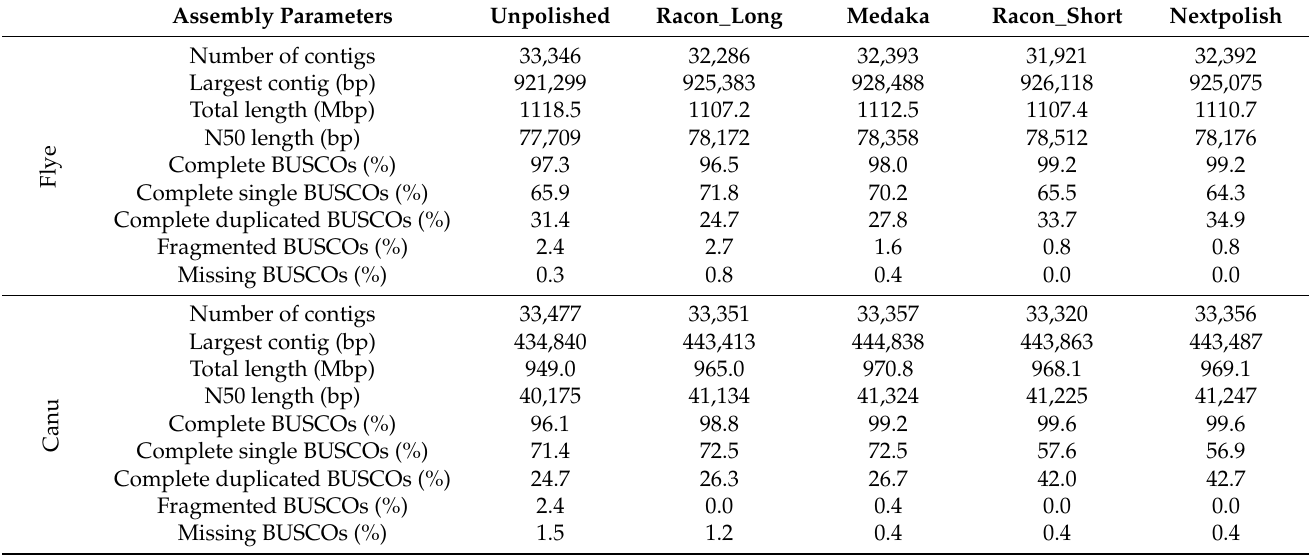
Table 4. Relevant assembly and BUSCO statistics for the unpolished and polished assemblies of the rooibos genome generated using the five long-read assembly programs: Flye, Canu, Raven, Redbean and